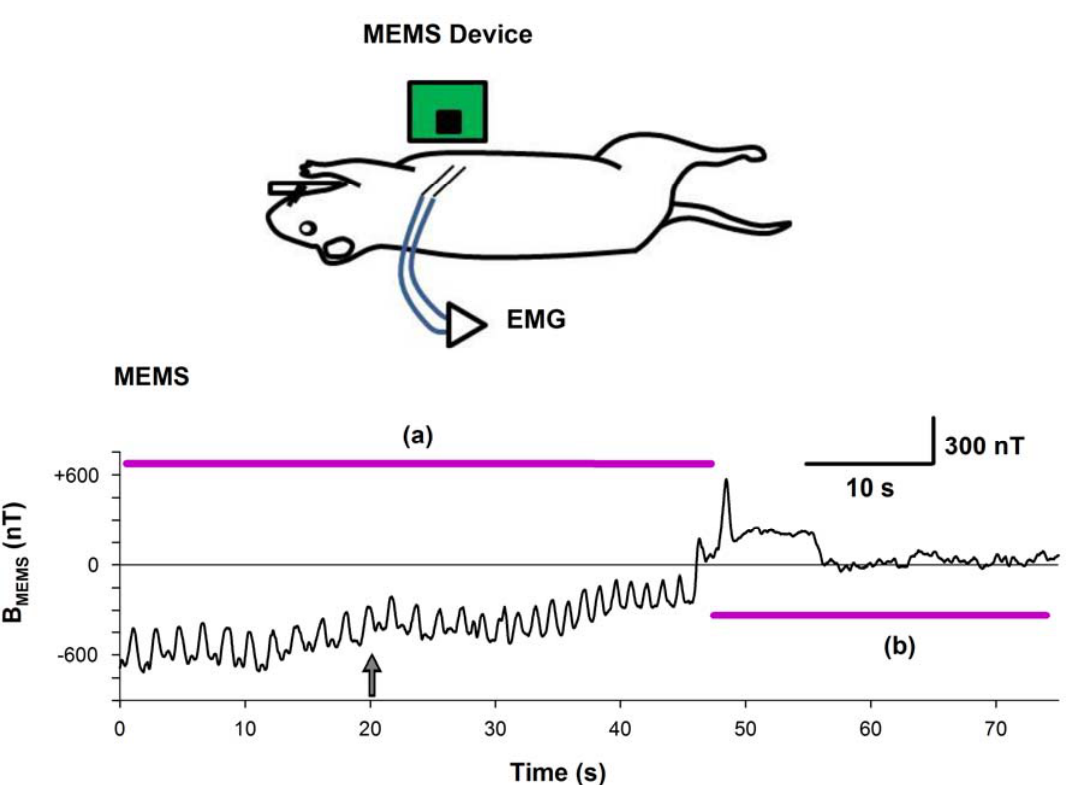
Figure 9. Upper panel, diagram of the experimental arrangement. ( a ) Magnetogram of a rat during respiration. ( b ) The same as (a) but after the rat was euthanized with an overdose of pentobarbitone. The computed power spectrum density (PSD) is depicted in ( c ) and ( d ) respectively. There are several frequency components during the respiration that subside after the euthanasia of the rat. We assumed the later condition as a “control” in which only background noise was present, while the respiration phase was considered as the noise+signal condition. The computed SNR between these signals was 17.62. B indicates the magnetic flux